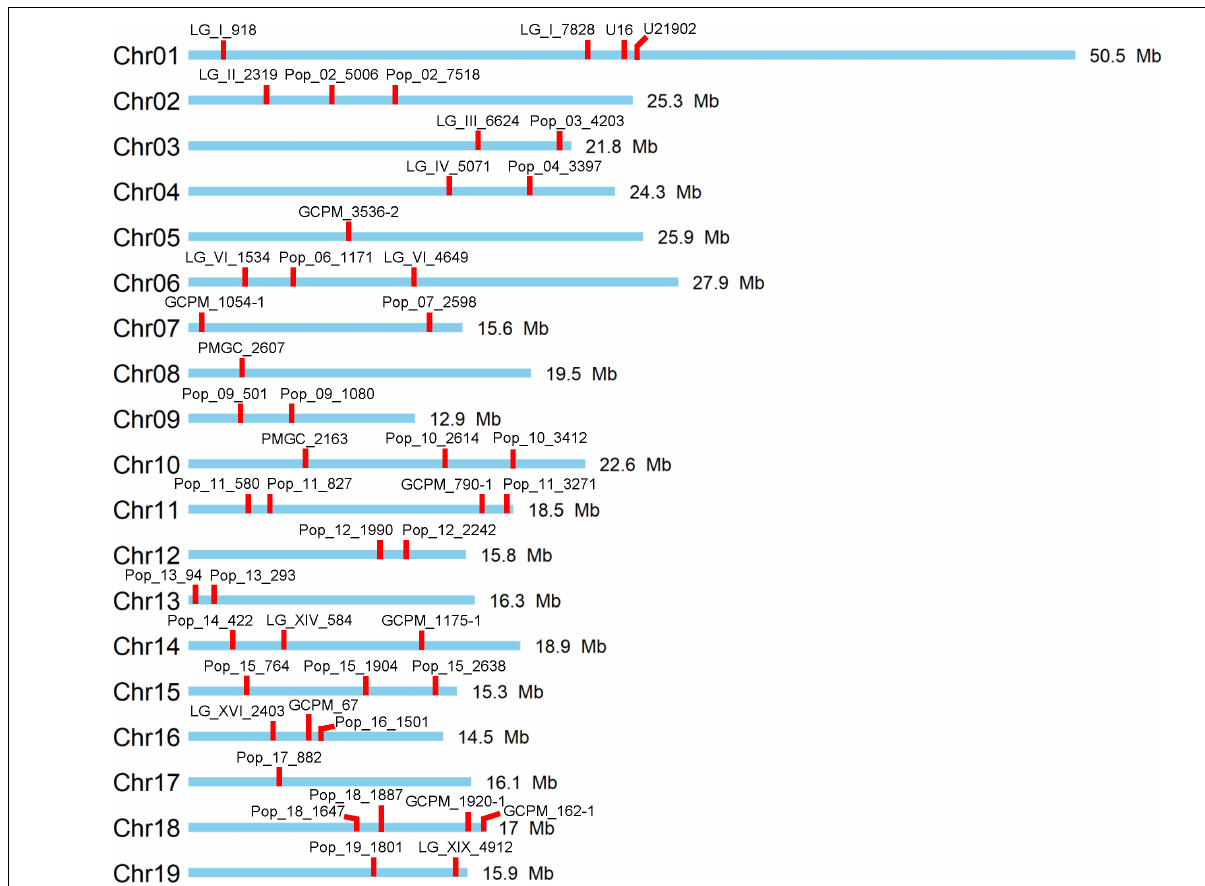
FIGURE 1 | Distribution of used 47 simple sequence repeat (SSR) markers on the 19 chromosomes of Populus .